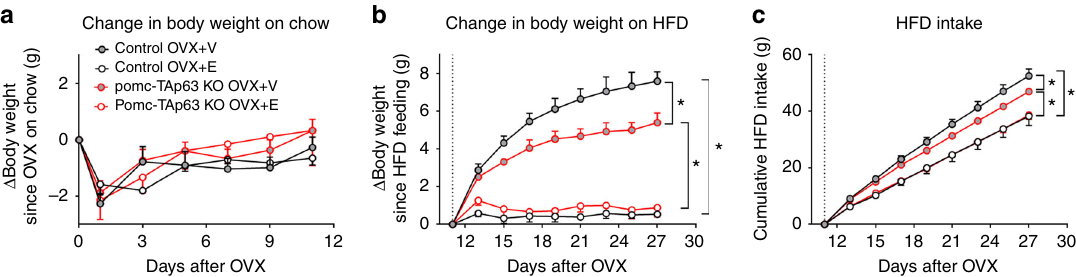
Fig. 4 Selective deletion of TAp63 in POMC neurons fails to affect the estrogen-induced anorexigenic effects in female mice. a , b Changes in body weight of female control or pomc-TAp63 KO mice that received OVX + V or OVX + E treatment, followed by 11-day chow feeding ( a ) and 16-day HFD feeding ( b ). c Cumulative food intake during the HFD feeding period. Data are presented as mean ± SEM. N = 4 or 5 per group. * P < 0.05 in two-way repeated ANOVA followed by post hoc Sidak tests